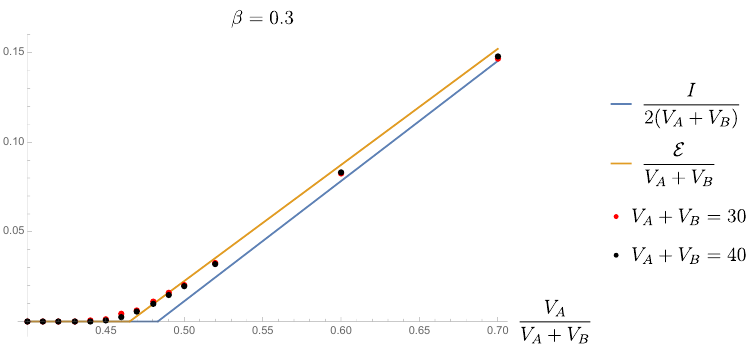
Figure 25 . Left: for I α given by (C.13), the logarithmic negativity is computed numerically using the resolvent (C.17) and compared to the naive analytic continuation in (4.53), (4.55) and (4.56), with excellent